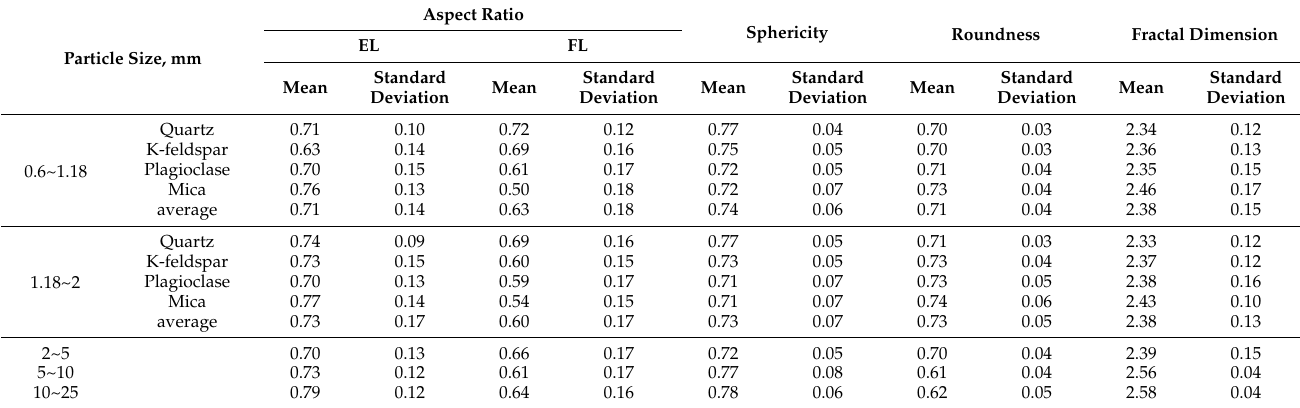
Table 1. Statistics of the 3D morphological descriptors at different particle